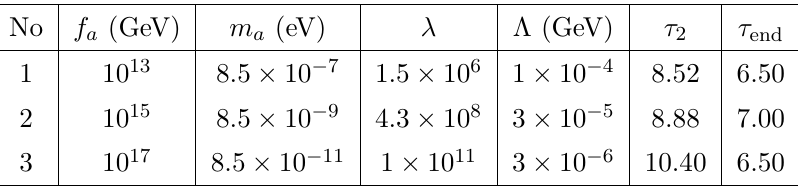
for the QCD axion. a , f a } , see eq. (6.1). It only assumes that T f a a < 1 . 8 · 10 11 GeV to be a